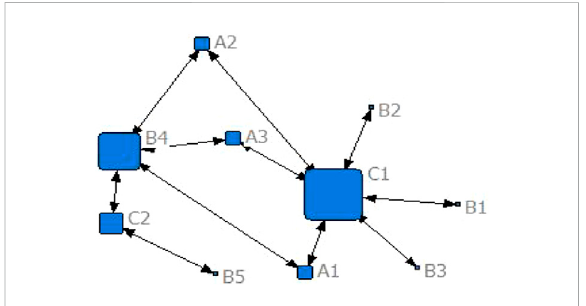
FIGURE 3 Network structure diagram. Legend: the larger the “ node square, ” the greater the betweenness degree.